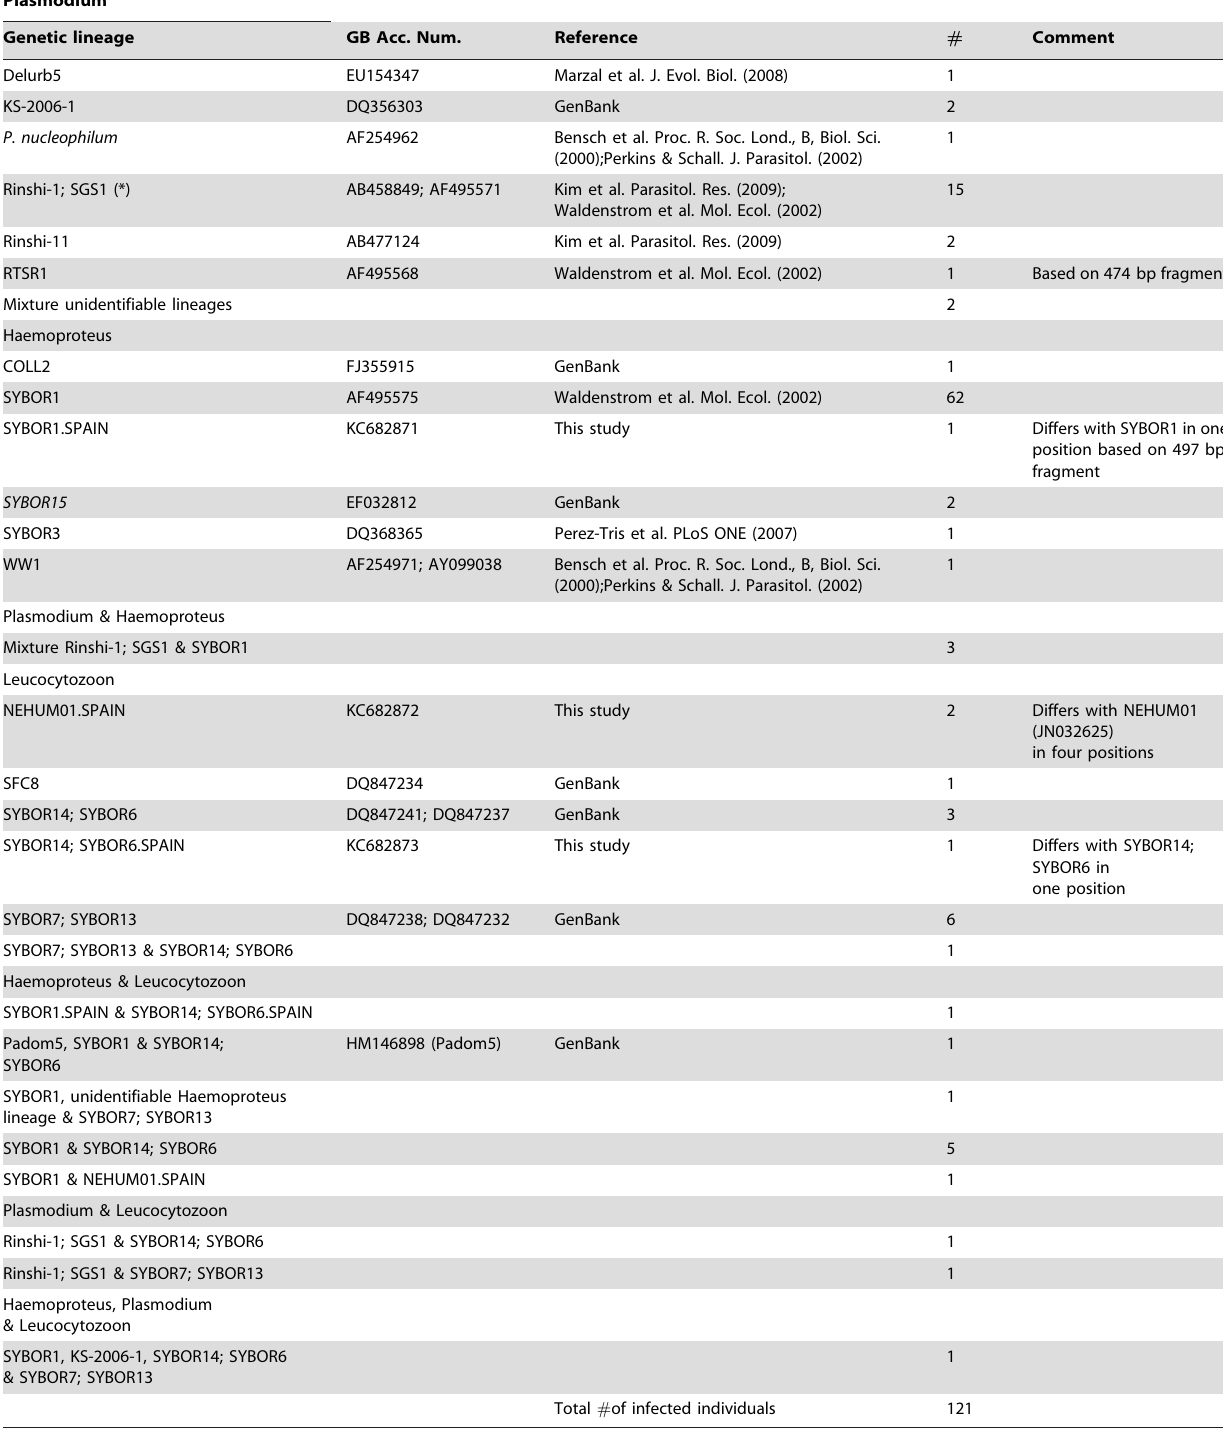
Table 3. Blood parasite genus and